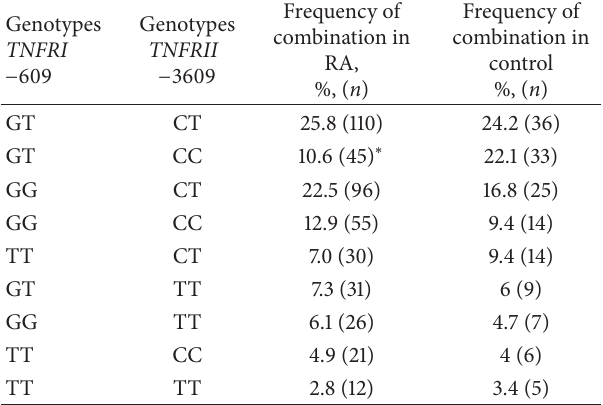
Table 4: Frequency of genotypes combinations of TNFRI and TNFRII in patients with rheumatoid arthritis and healthy individ-